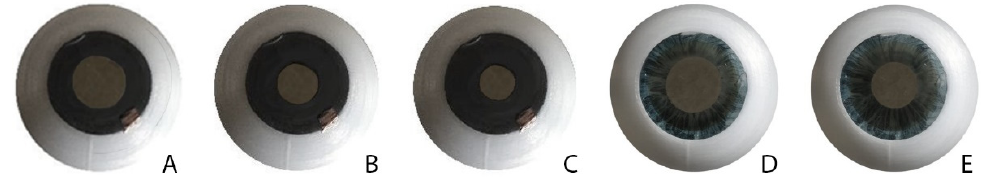
Figure 3. Graphene DEA test without iris overlay to measure the maximum and minimum pupil ranges: ( A ) DEA deactivated; ( B ) DEA activated at 1000 v, 2a. Approx. 21% reduction in DEA; ( C ) DEA activated at 2000 v, 2a. Approx. 58% reduction. DEA test with colourised Iris and gelatin overlay; ( D ) DEA deactivated; ( E ) DEA activated at 2000 v, 2a. Approx. 39% reduction in DEA.